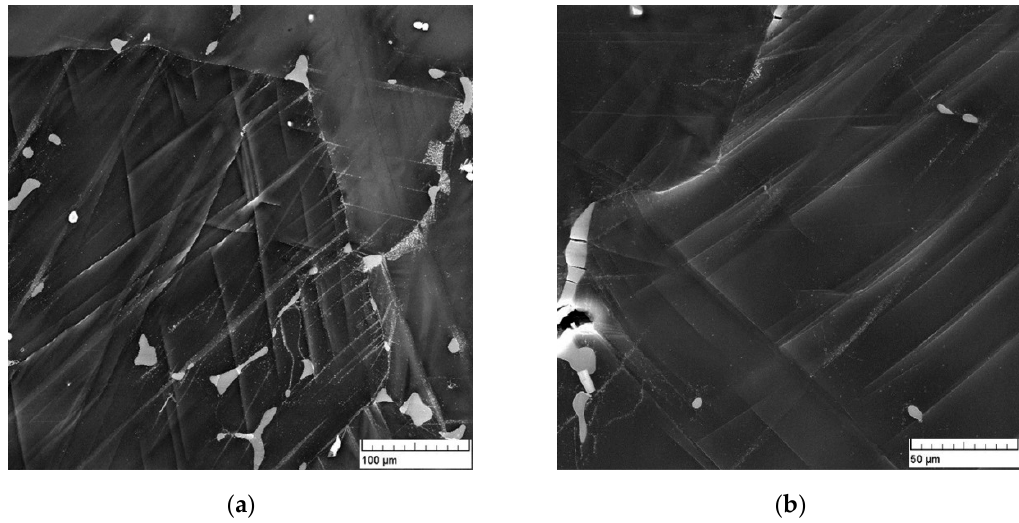
Figure 17. Traces of plastic deformation on the AZ91 alloy surface. ( a ) Deformation bands of two slip systems. ( b ) Details of the strain bands.